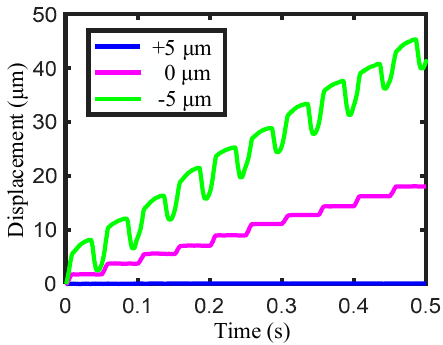
Figure 17. Motion characteristics of the slider under various gaps.